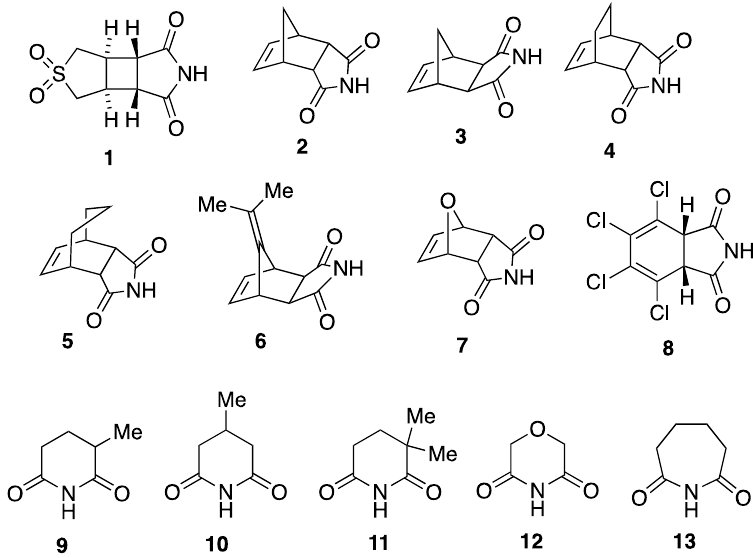
Figure 2. Cyclic NH imides for which structures were